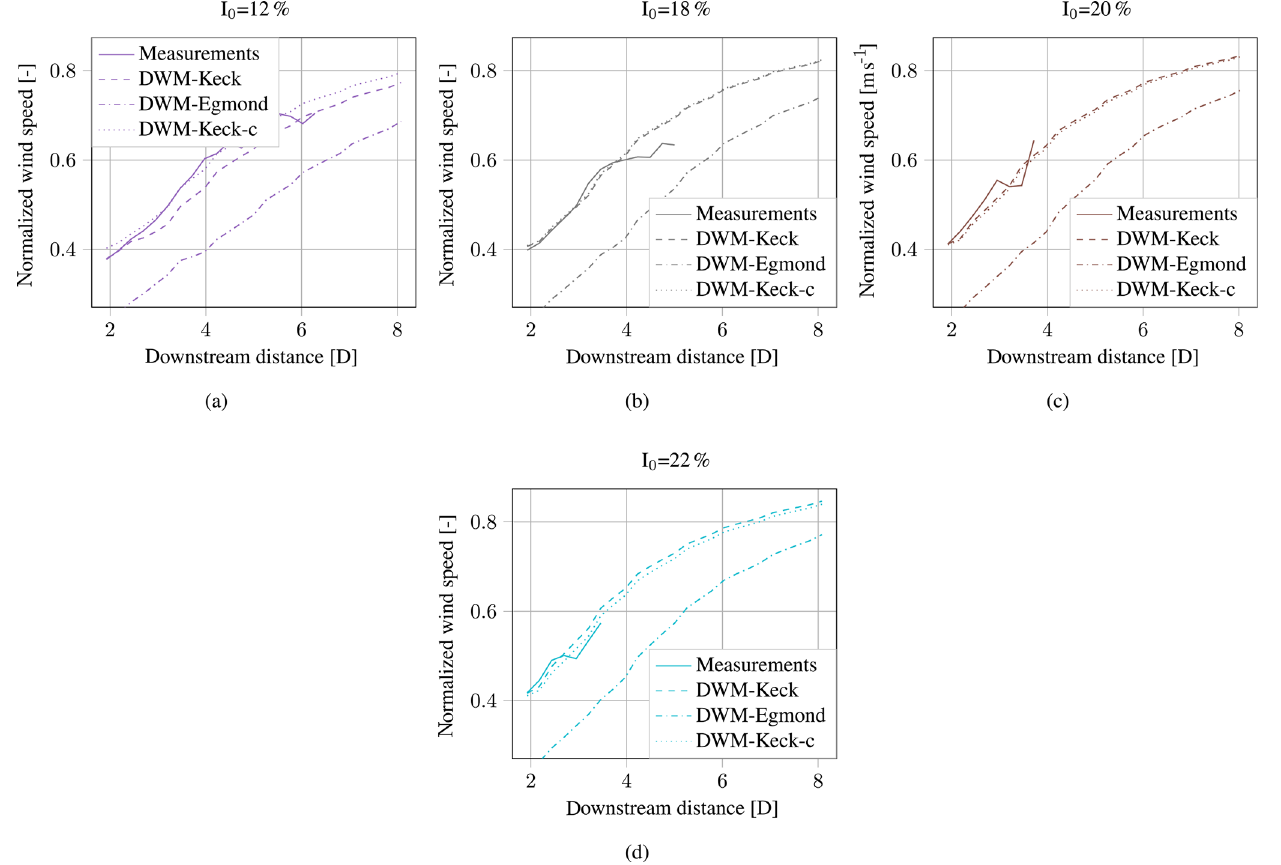
Figure B2. Comparison of measurements and simulations of the minimum wind speed deficit in the HMFR for different turbulence intensi- ties. The recalibrated model is denoted